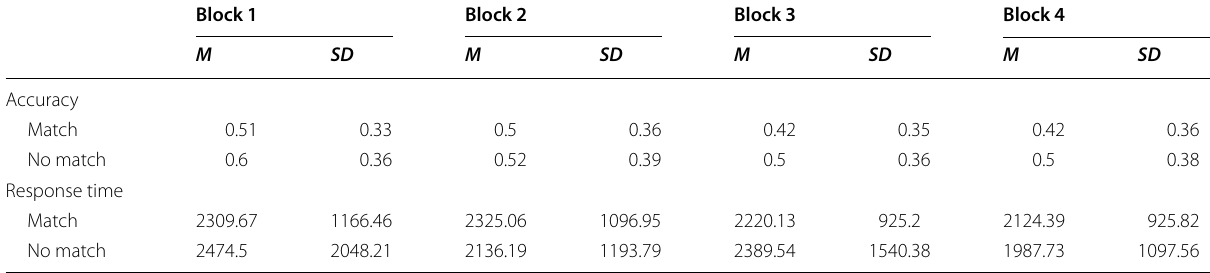
Table 3 Prospective memory accuracy and response time across blocks in the prior experience condition in Experiment 1 Block